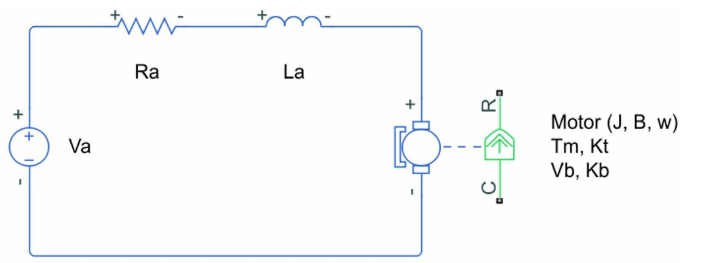
Figure 1. DC motor electro-mechanical schematic; w = ω is the angular speed generated by an input voltage V a